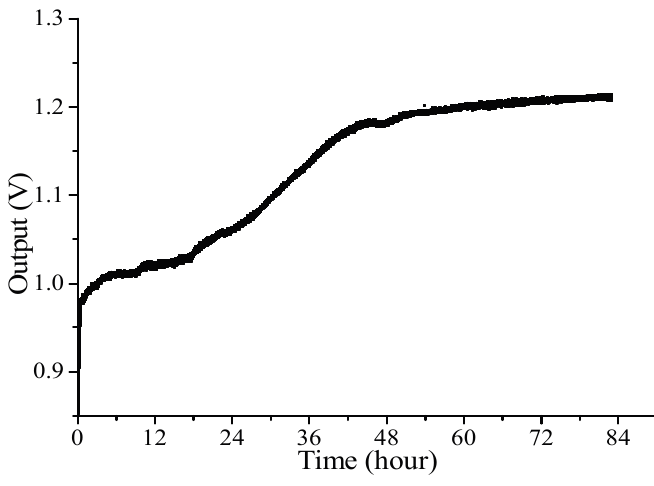
Figure 4. Fresnel reflectivity variation at room